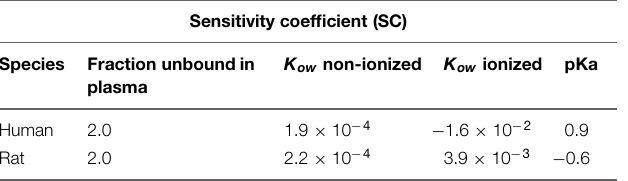
TABLE 3 | Sensitivity analysis for selected parameters for generalized compound plasma:saliva partitioning coefficent.